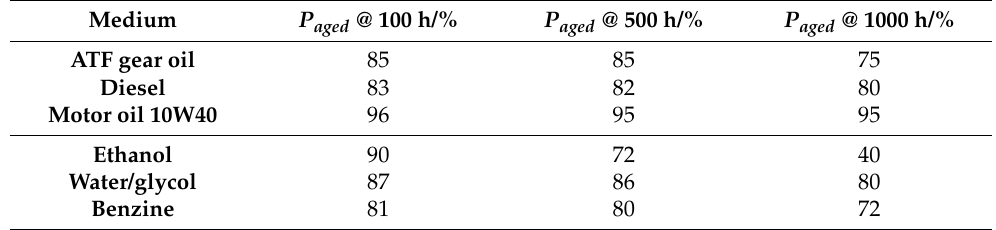
Table 3. Ageing guidelines for di ff erent mediums, based on the compression shear strength of alu- minium single lap joints of aged specimens against unaged specimens. Obtained from the adhe- sive’s datasheet.